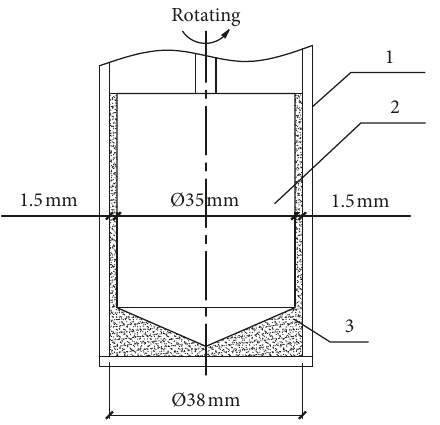
Figure 2: Scheme of cylinder-measuring system Rheotest RN 4.1.